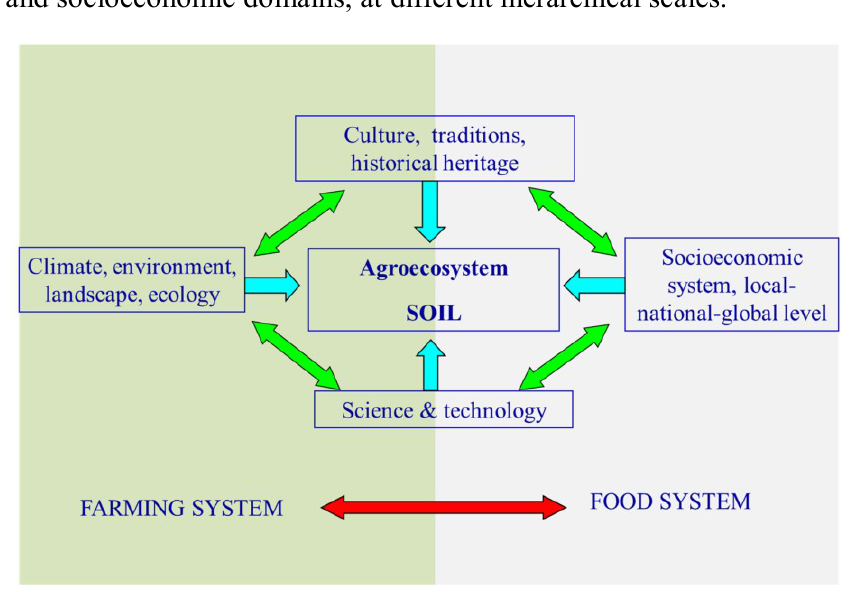
Figure 1. Soil and agroecosystems are complexly interwoven with the environmental, ecological and socioeconomic domains, at different hierarchical